Question: What visual encoding does this figure use to show its data?
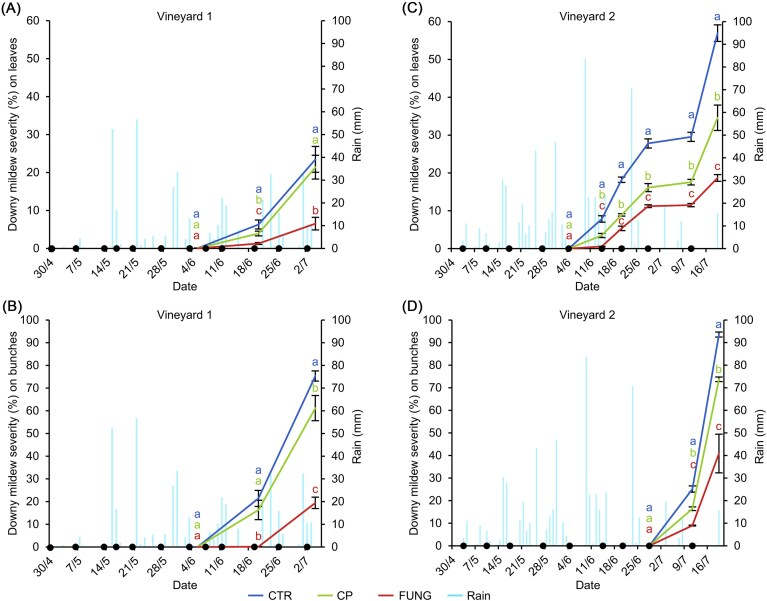
Answer: bar